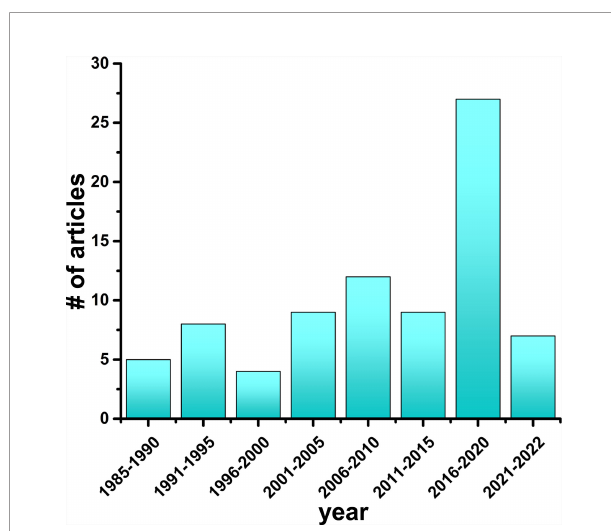
FIGURE 3 | Simulation studies on the hormone insulin (1985 – 2022). The number of research articles on MD simulations of insulin published every 5- year time interval is